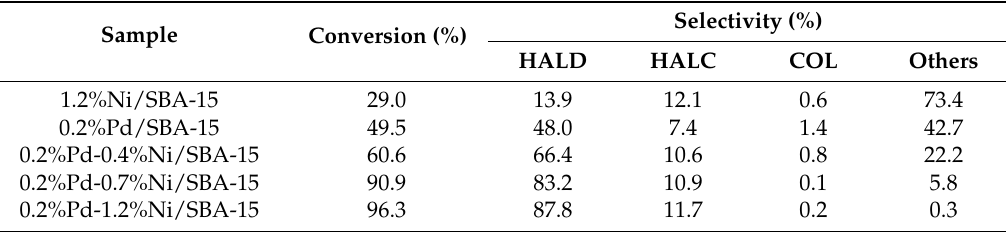
Table 3. Selective hydrogenation activity of CAL over 0.2%Pd-x%Ni/SBA-15 a .